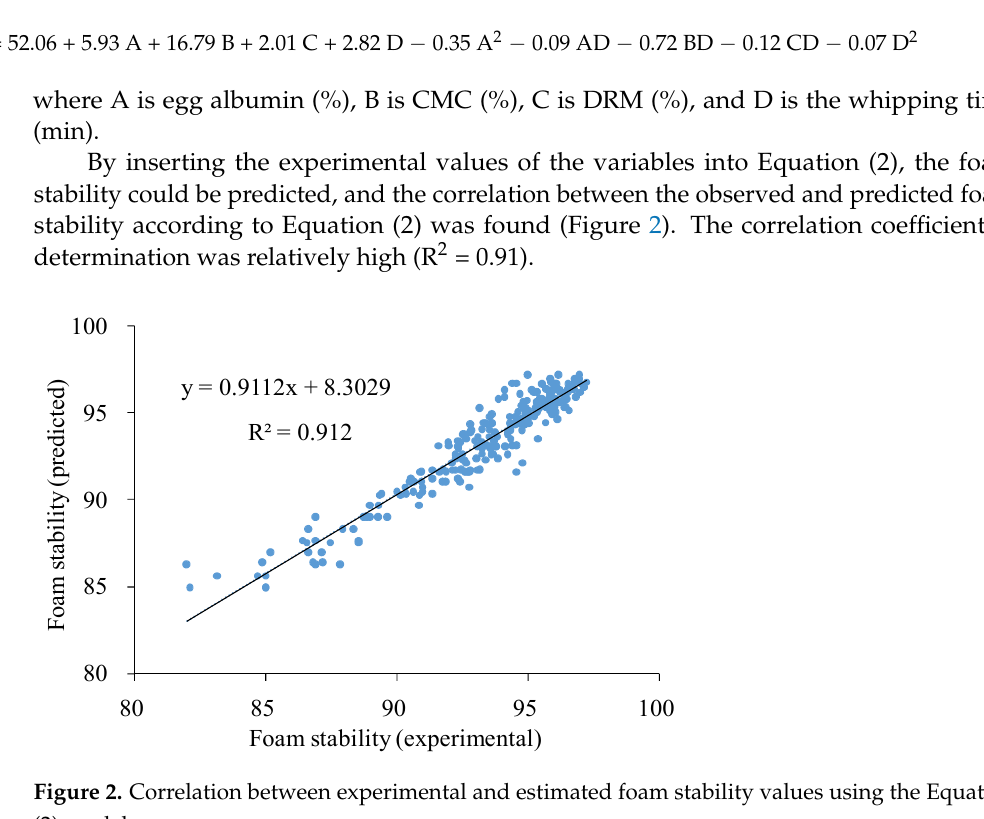
Figure 2. Correlation between experimental and estimated foam stability values using the Equation (2) model.